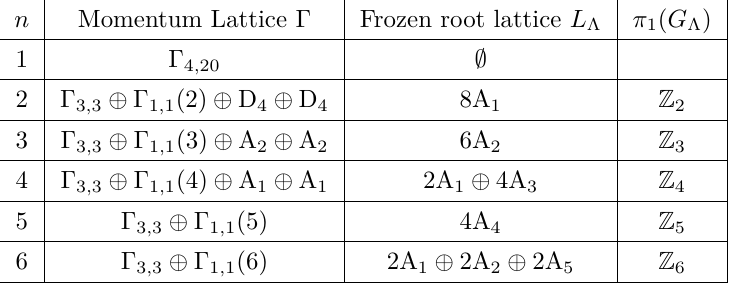
Table 3 . Momentum lattices and corresponding orthogonal complements in Γ 4 , 20 , given in terms of their root sublattices and fundamental group of the associated gauge